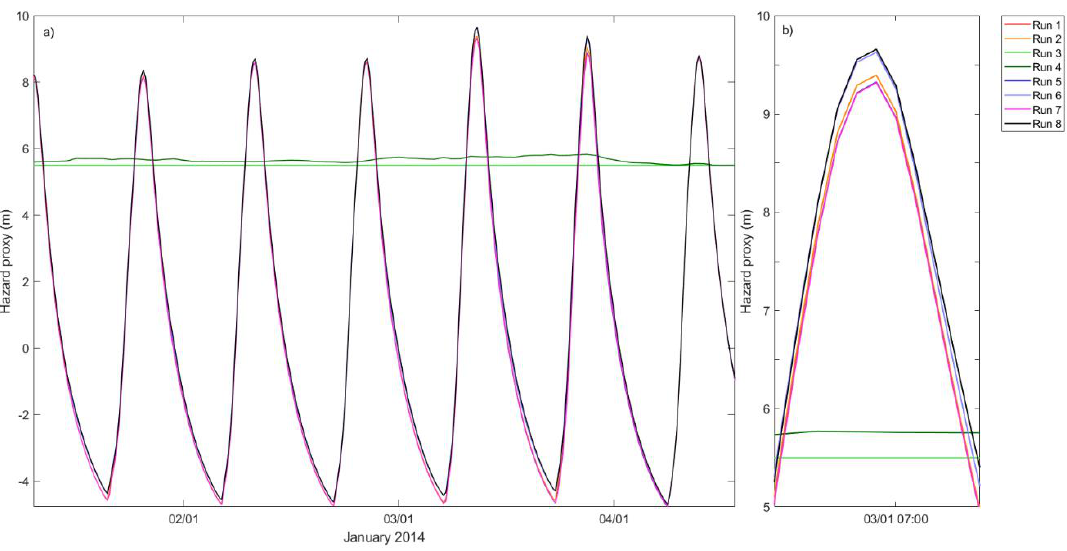
Figure 3. ( a ) Coastal hazard uncertainty time series from Delft3D used to force LISFLOOD-FP, for January 14 event using the HP approach, shown here as an example; ( b ) zoom of peak of the January 14 event to show coastal hazard 14 event to show coastal hazard uncertainty.